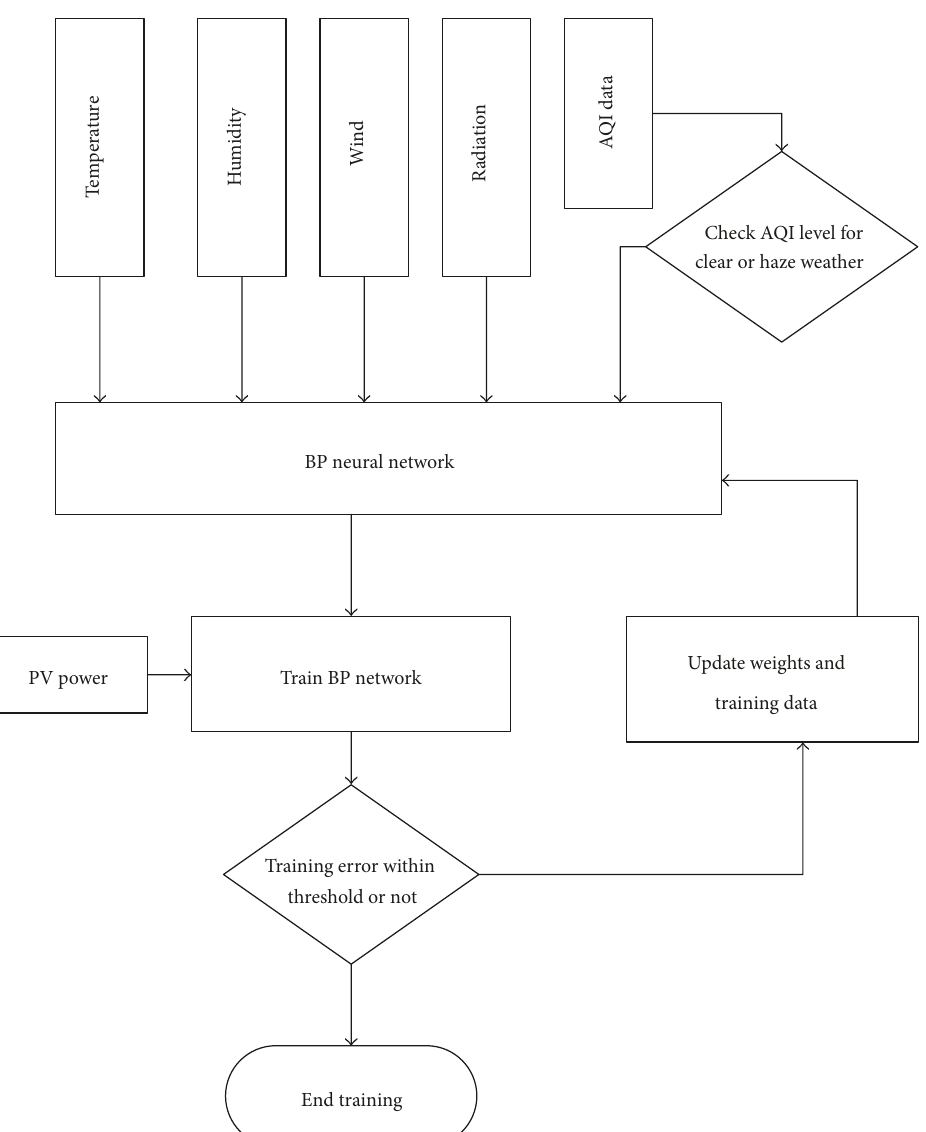
Figure 3: Training network with historic input